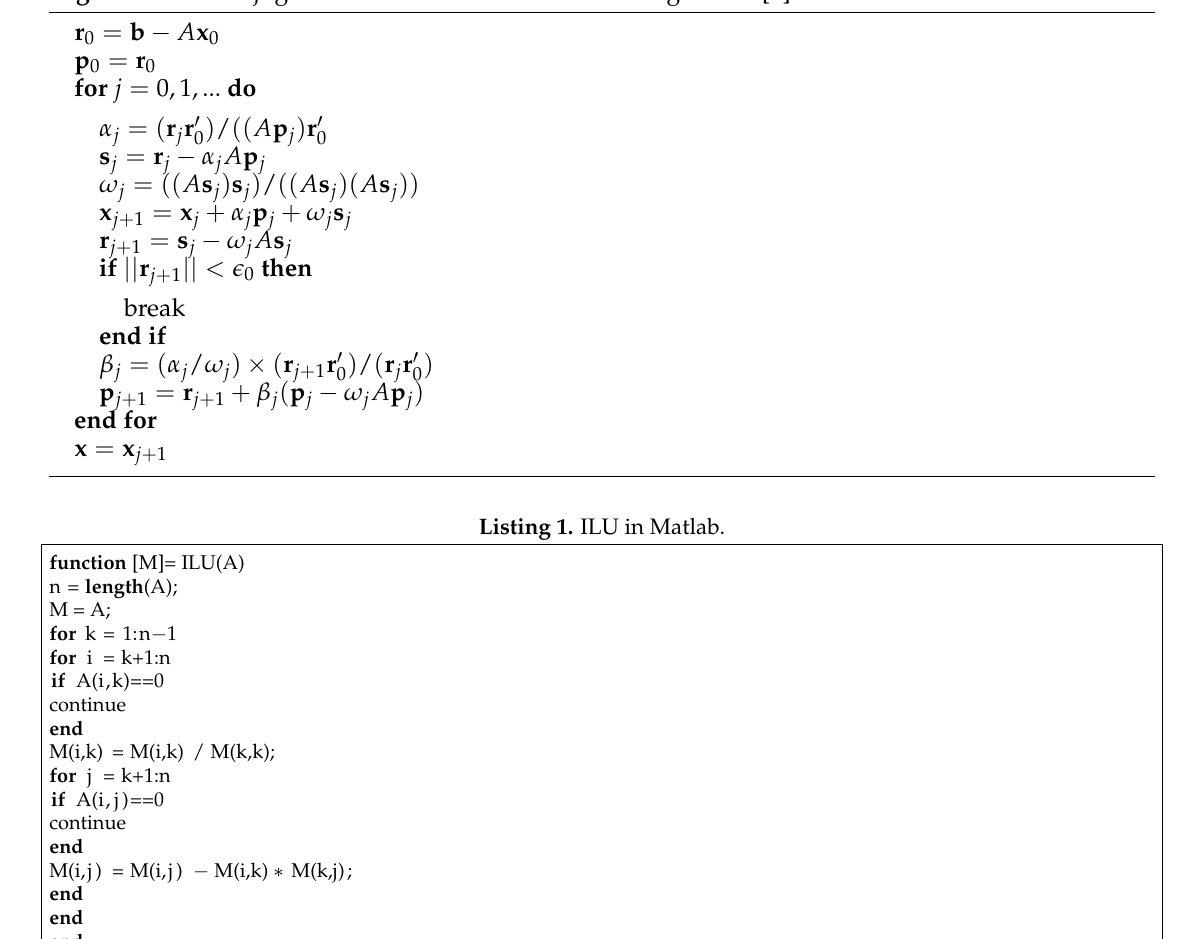
Algorithm 1 Biconjugate Gradient Stabilized Method Algorithm